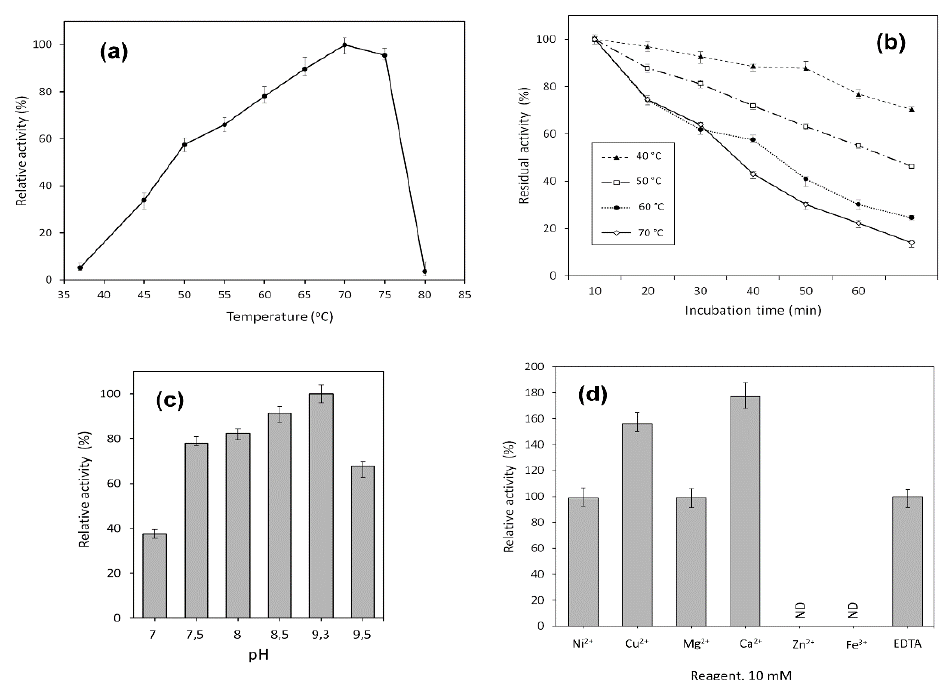
Figure 3. Effect of temperature on ( a ) activity, and ( b ) stability of MrAII. Stability is expressed as residual activity (%) after 0–60 min of incubation. Effects of ( c ) pH, and ( d ) various metal cations, on the catalytic activity of the MrAII; ND, not defined.